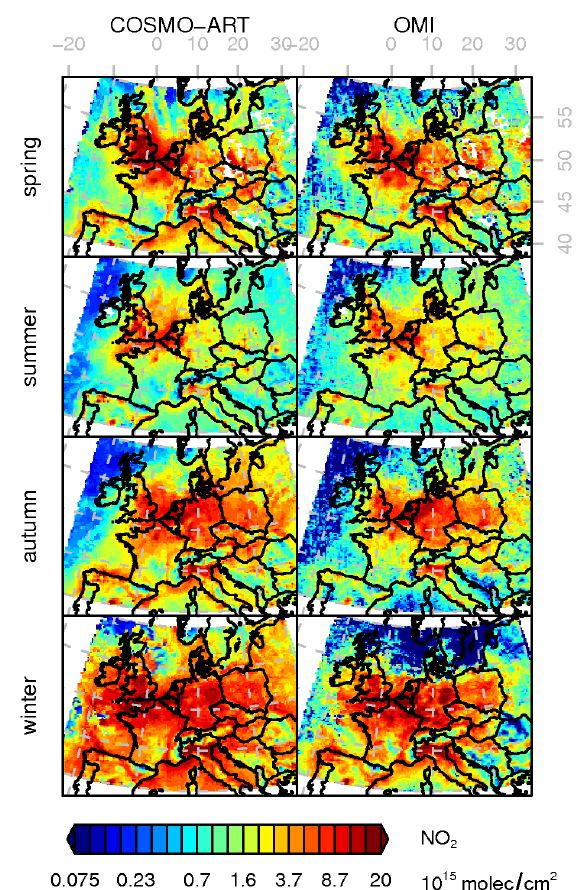
Fig. 6. Comparison of modelled NO 2 VTCs against OMI satellite data for (from top) the spring 2009, summer 2006, autumn 2008 and winter 2006 periods. Modelled values are found in the left column, OMI observations in the right one. Not the whole simulation domain could be compared due to missing coverage of the EOMINO dataset.